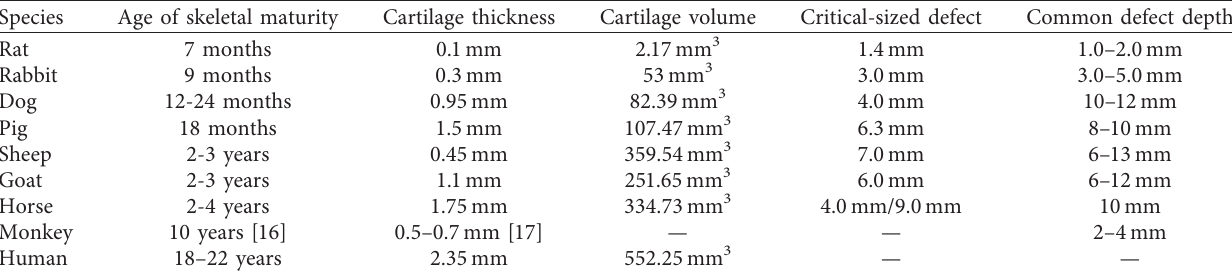
Table 1: Comparison of age, cartilage, and defect size in different